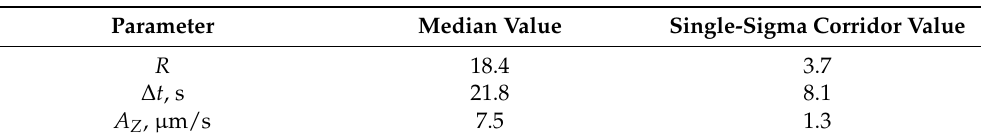
Table 1. Statistical values for selected parameters characterizing the subgrade reaction to the vibration effects created by trains in the ultra-low-frequency